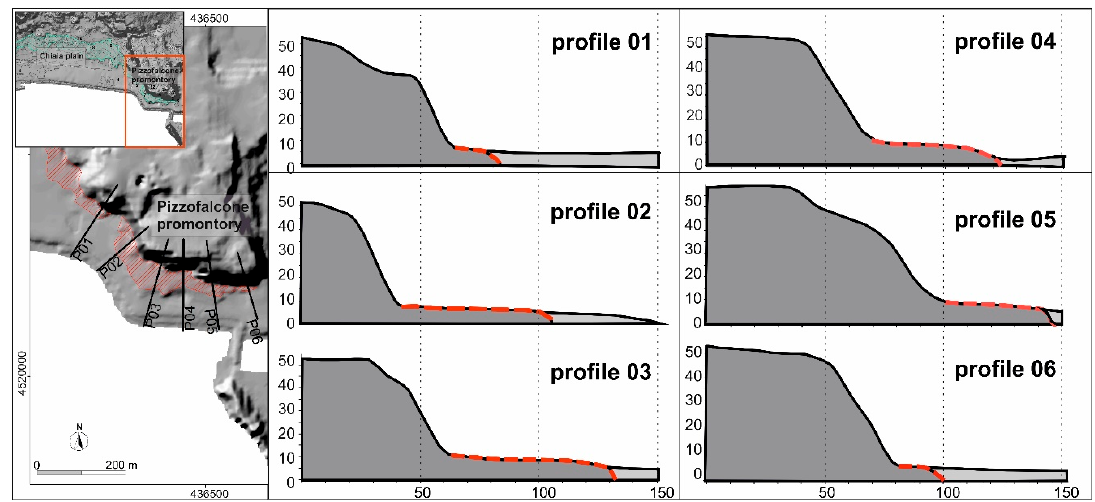
Figure 7. Six topographic profiles across the first-order platform (x and y axis are in metres): the black line is the present profile; the dotted red line is the original profile of the terrace and the light-grey area is the artificial anthropic infill built in the last 150 years. The green area in the inset map defines the perimeter of the 1st order platform and the red box represent the area in which the six profiles were reconstructed.